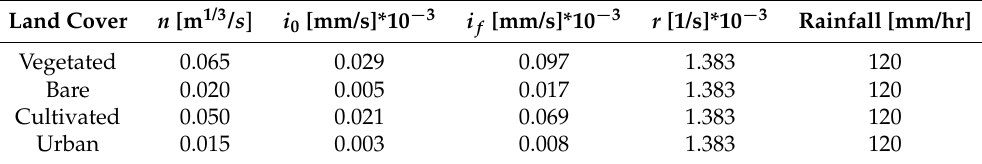
Table 4. Model parameters used for the sensitivity to Manning’s coefficient scenario.